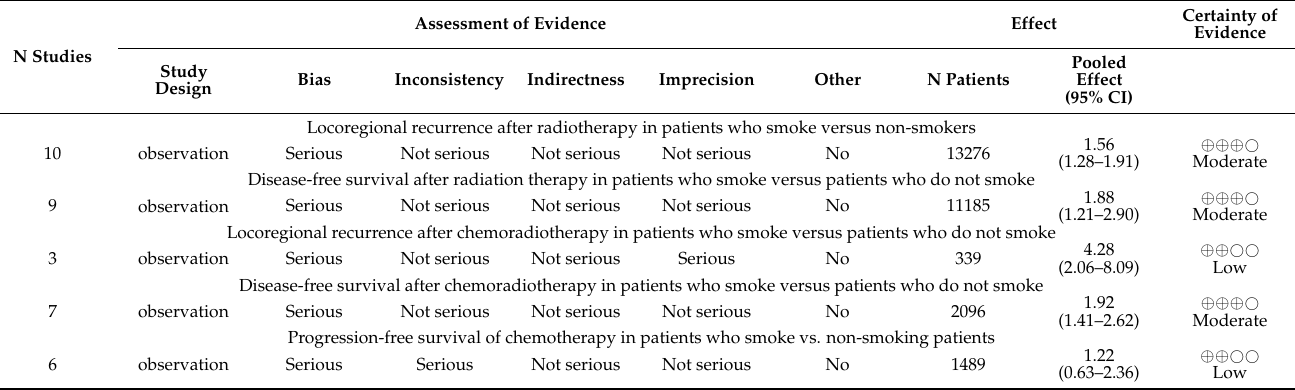
Table 1. Certainty of evidence on the impact of smoking on treatment efficacy and toxicity with GRADE